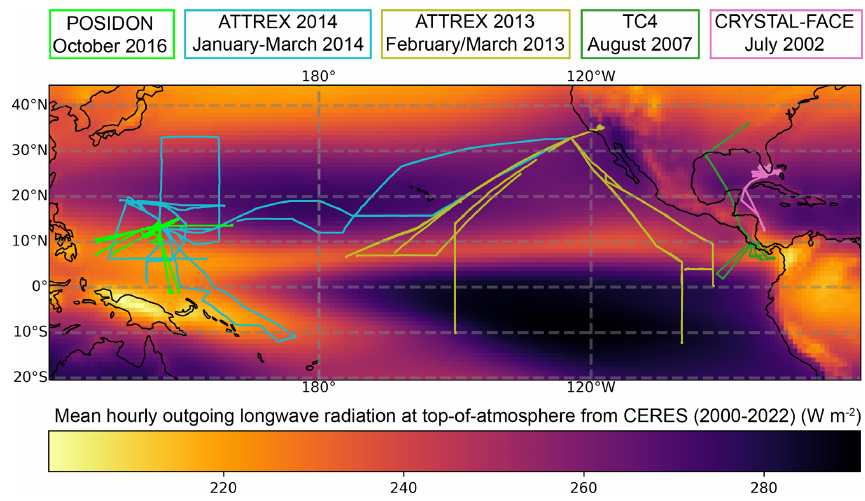
Figure 1. Map of mean top-of-atmosphere outgoing longwave radiation from CERES, with flight tracks from the five campaigns used in this study